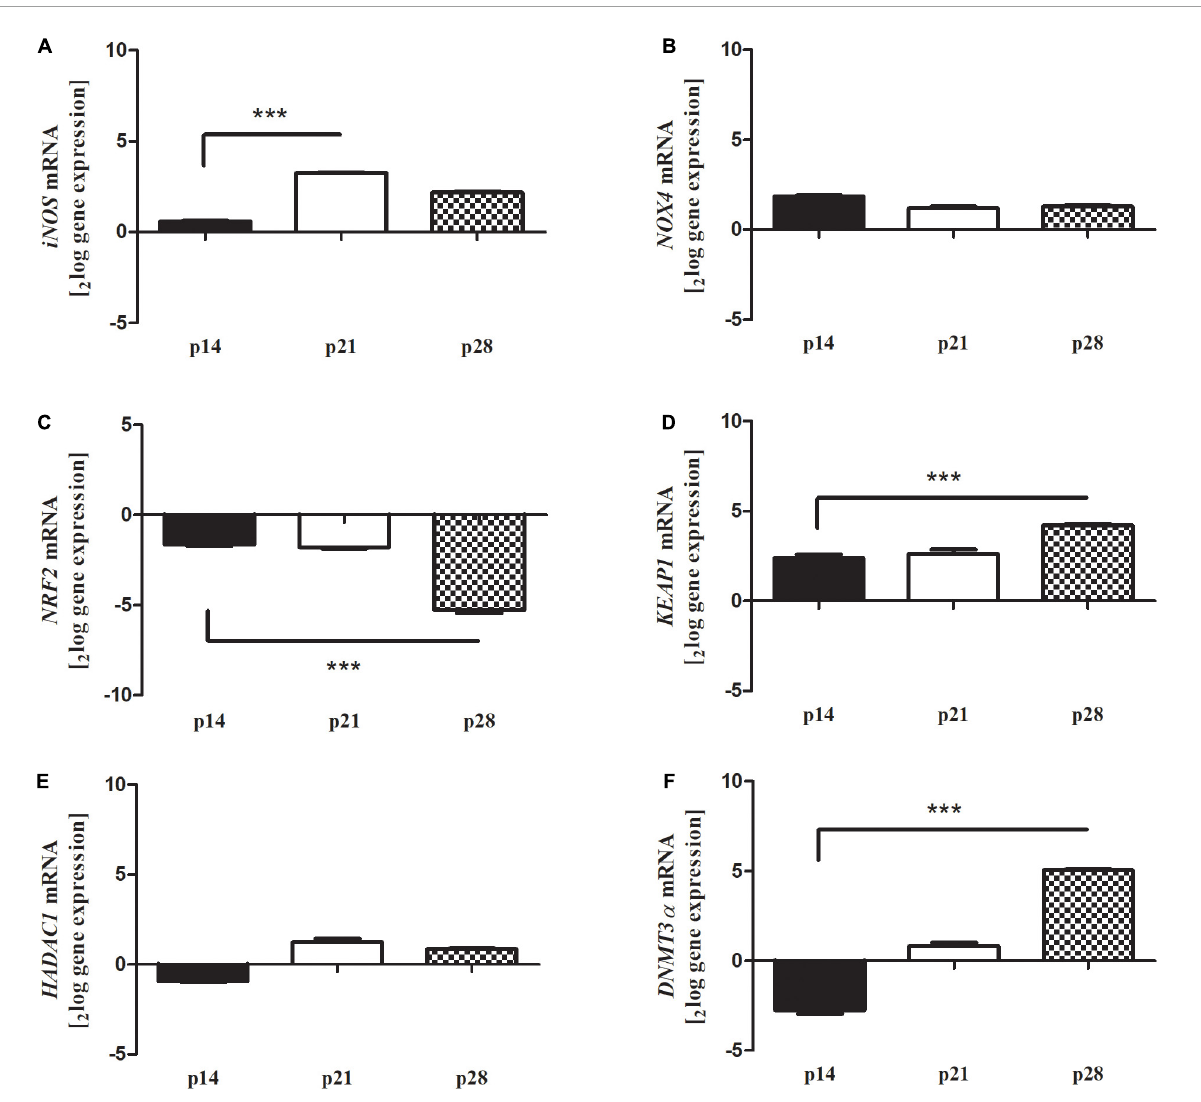
FIGURE6 Differential expression of oxidative stress markers in Reeler retina. Total RNA was extracted from non-pooled retinas and used to generate cDNA for real time PCR analysis. Histograms show a significant transcript upregulation for oxidative stress markers [ (A) iNOS, (D) KEAP1 and (F) DNMT3a ] and a significant downregulation of (C) NRF2 at p28 in Reeler retinas as compared to WT ones; REST analysis). No significant changes were detected for (B) NOX4 and (E) HDAC1 . Data are 2logFC gene expression (mean ± SEM, Reeler vs. WT) and p values are shown by asterisks (*** p <